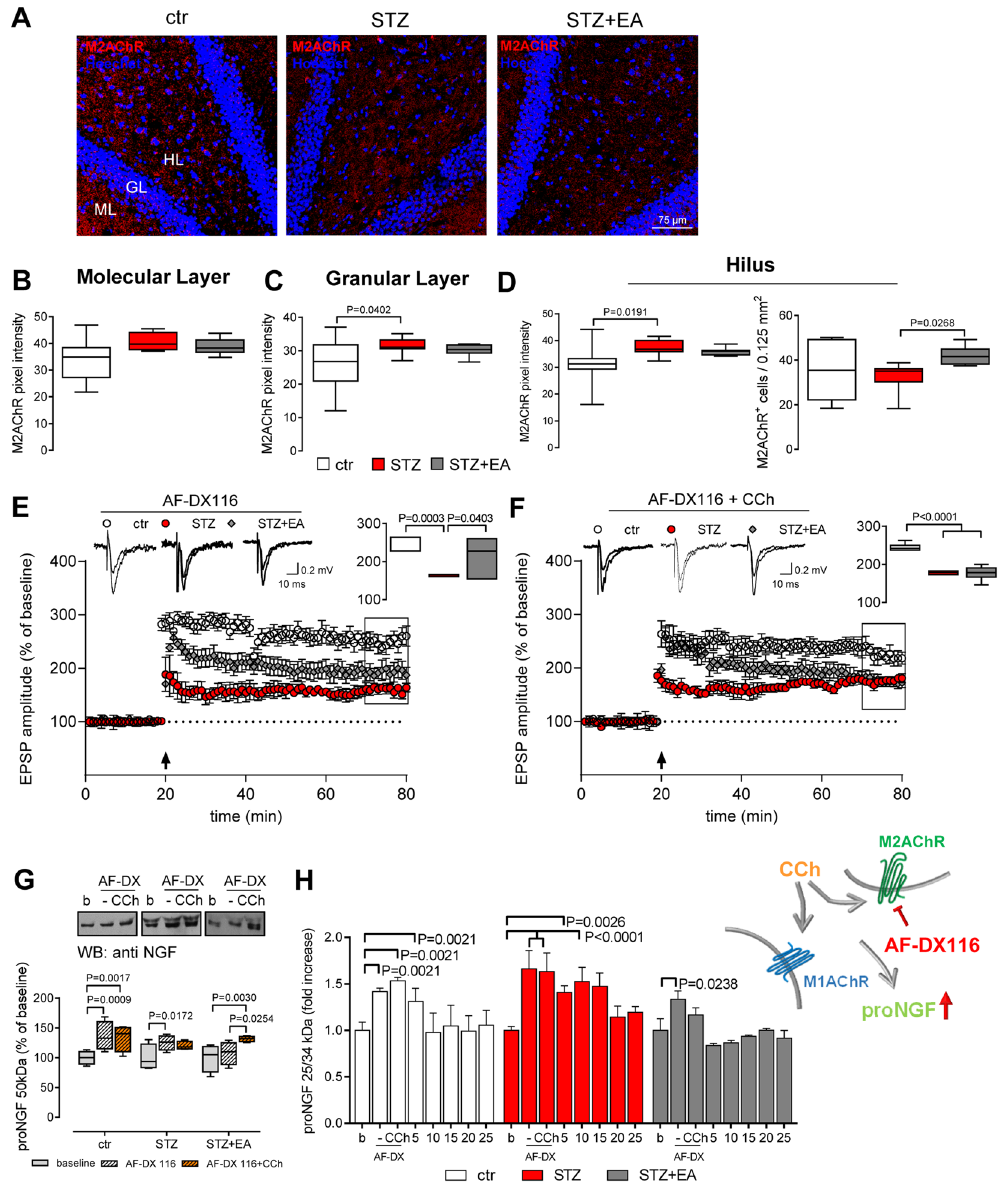
Figure 5. Diabetes- and electroacupuncture-modified M2AChR expression and its influence on LTP and proNGF secretion. ( A ) Representative images of M2AChR immunolocalization in the dentate gyrus (DG) of the hippocampus. ( B–D ) Mean pixel intensity of M2AChR immunostaining in different areas of the DG and number of M2AChR immunopositive (M2AChR + ) cells in the hilus. No immune-positive cells were detected in the granular layer (GL). Means ± SEM (n = 8 fields, 4 animals for each experimental group). One- way ANOVA followed by Bonferroni multiple comparison test, P values shown in figure. ( E , F ) Long-term potentiation at DG (DG-LTP) after stimulation of hippocampal slices with the M2AChR selective antagonist AF-DX116 and the nonselective muscarinic agonist carbachol (CCh). Field excitatory postsynaptic potentials (fEPSP) were recorded and expressed as the percentage of the pre-tetanus baseline. Changes in fEPSP slopes before and 60 min after the induction of LTP by high-frequency stimulation (HFS) of the medial perforant pathway (black arrow) are shown (means ± SEM; n = 8 for each experimental group). The insets represent typical fEPSP recordings; calibration bars: 0.5 mV, 10 ms. The average of DG-LTP magnitude 50–60 min after HFS is presented on the right side of the panels (median ± interquartile range, whiskers: min. and max.). One-way ANOVA and Bonferroni multiple comparison, P values shown in figure. ( G ) Carbachol-stimulated proNGF release from hippocampal slices. AF-DX116 was added to the superfusion bath before hippocampal slices were exposed to carbachol. Densitometry of the Western blots (cropped representatives shown in the upper side of the panel; full-length blots are shown in online Supplementary material) illustrates the differences in AF-DX116/carbachol-stimulated proNGF release among experimental groups. Data are the percentage of respective baselines (median ± interquartile range, whiskers: min. and max.; n = 6 for each experimental group). Repeated-measure ANOVA followed by Bonferroni multiple comparison, P values shown in figure. (H) Carbachol-stimulated 25/34 kDa proNGF release from hippocampal slices measured by proNGF